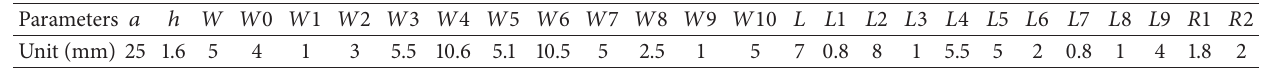
Figure 4: Simulated VSWR of the three kinds of antennas: proposed, without open stub, and without slot antennas. Table 1: Design parameters of the proposed UWB